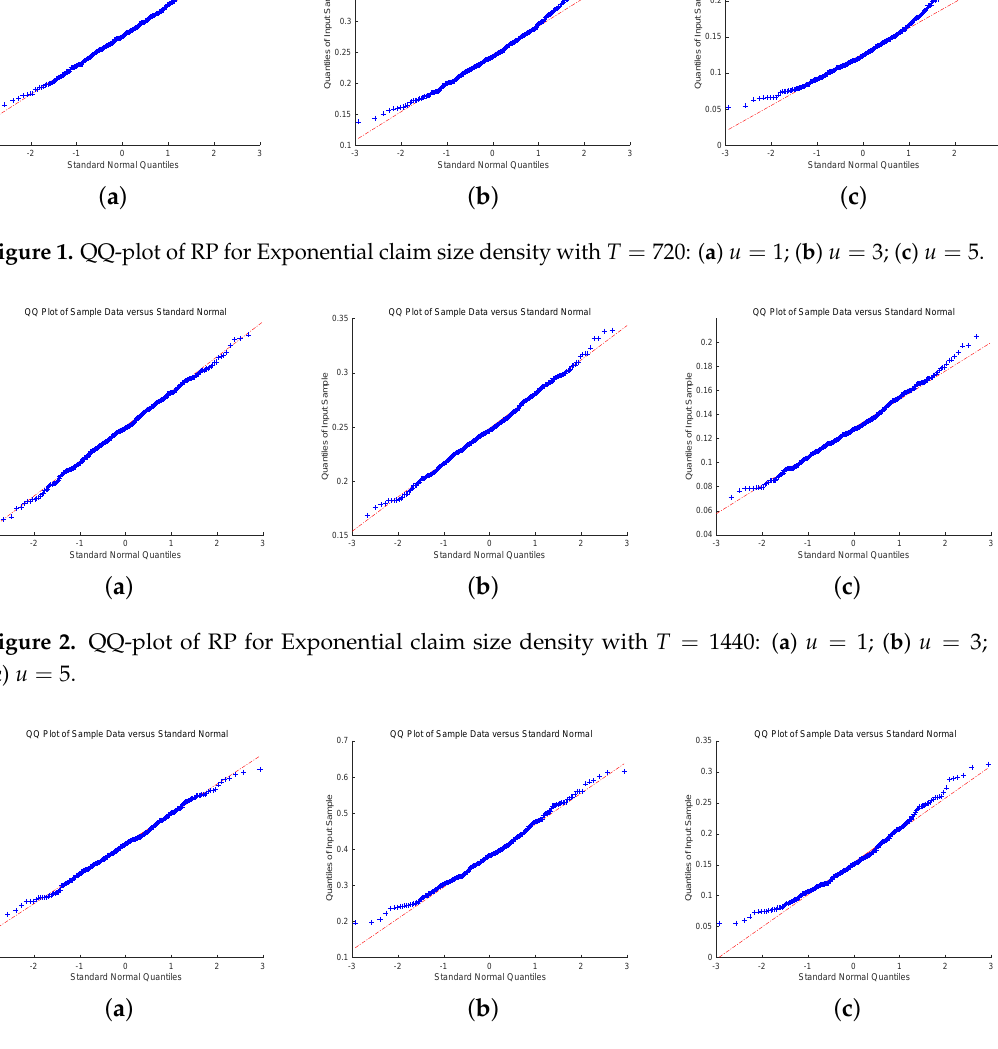
Figure 3. QQ-plot of ECS for Erlang(2) density with T = 720: ( a ) u = 1; ( b ) u = 3; ( c ) u =